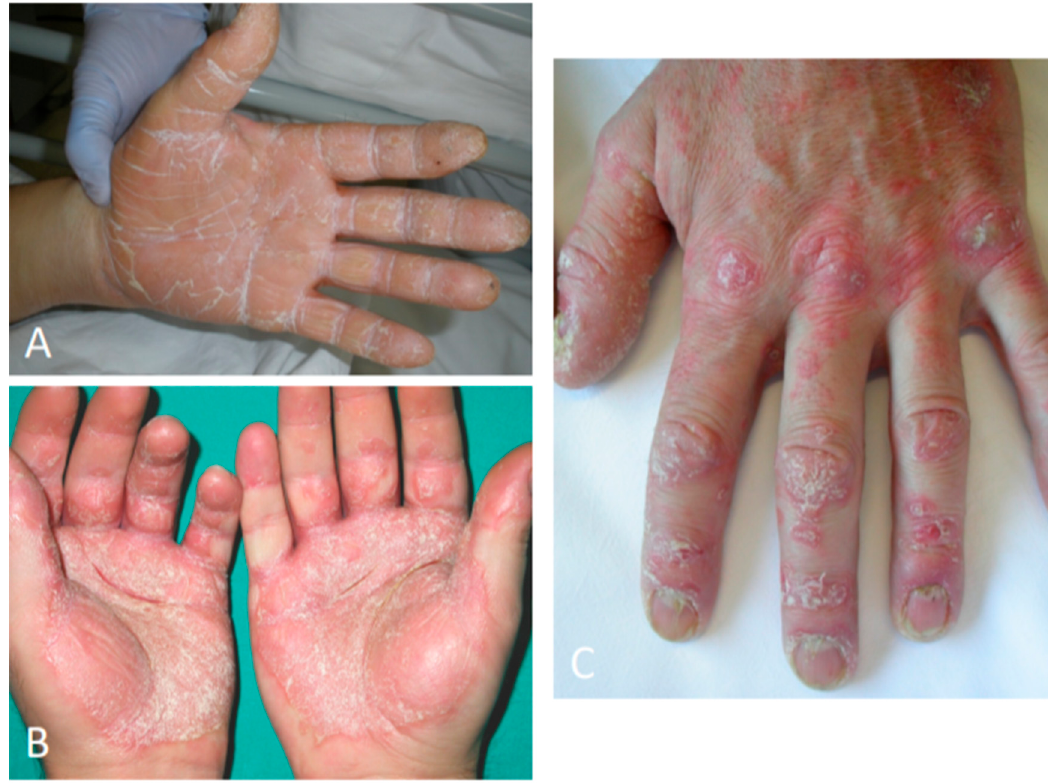
Figure 4. Palmoplantar psoriasis presenting with hyperkeratotic and erythematous plaques of the palmar surfaces of the hands ( A ), fissures ( B ), and digital and nail involvement ( C ).